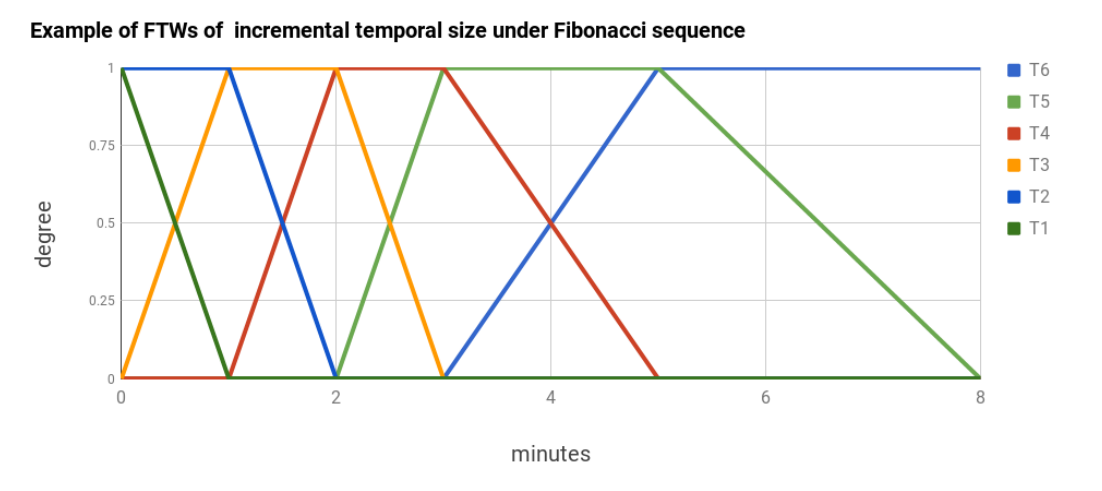
Figure 2. An example of incremental size for FTWs is straightforwardly defined by Fibonacci